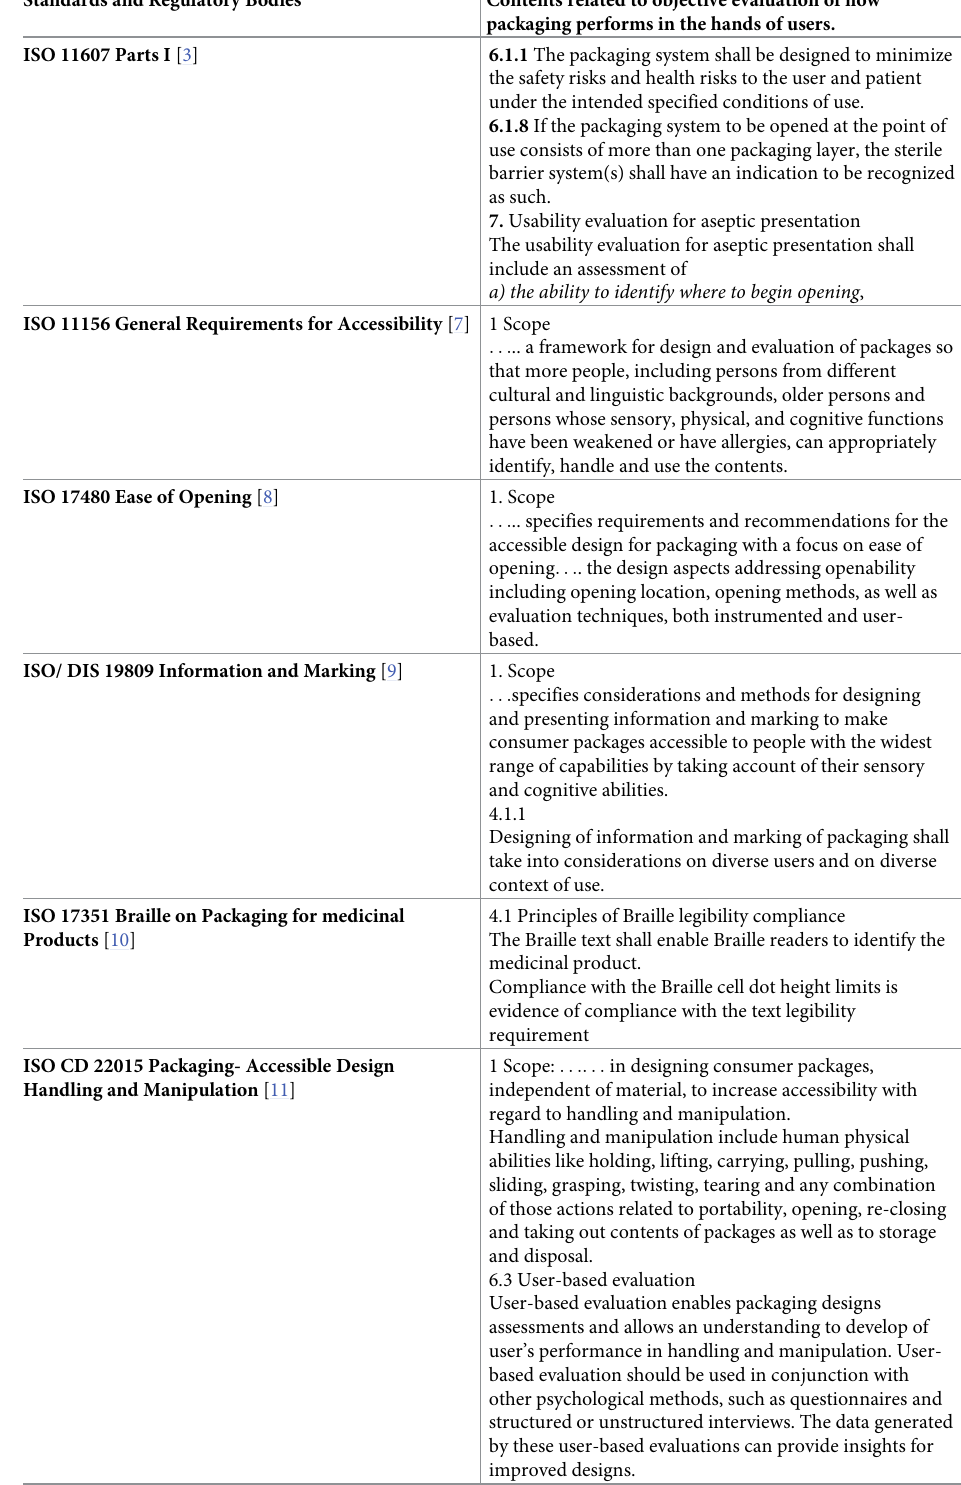
Table 1. Objective evaluation and regulatory documents by